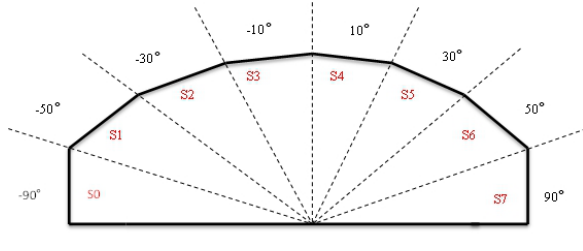
Figure 2: Placement of ultrasonic sensors on Pioneer 3-DX